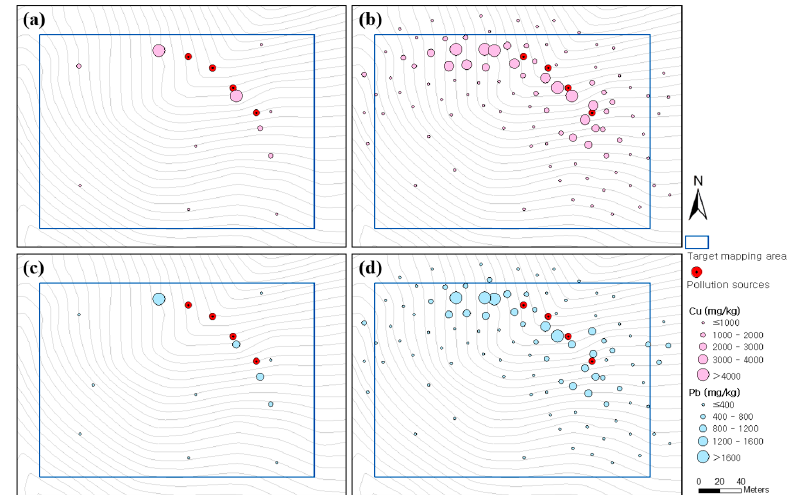
Figure 2. Results of element analysis: ( a , c ) Copper and lead contents in soil analyzed by ICP–AES, respectively; and ( b , d ) copper and lead contents in soil analyzed by PXRF, respectively. The ICP–AES analysis results for the 11 validation samples are not illustrated. Table 2. Results of element analysis by using the ICP–AES instrument for 23 soil samples. Electrical conductivity (EC) and pH of the soil samples are also provided. The sample locations are shown in Figure 1.